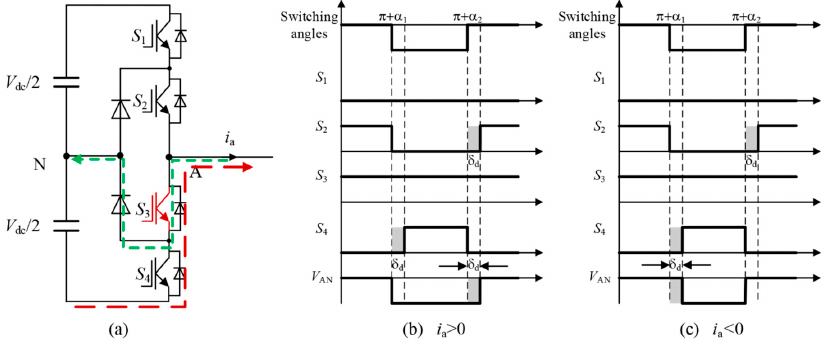
Figure 5. Current path ( a ), and output voltage during dead time, when i a > 0 ( b ), and i a < 0 ( c ), in the Figure 6. Current path ( a ), and output voltage during dead time, when 𝑖 (cid:3028) (cid:3408) 0 ( b ), and 𝑖 (cid:3028) (cid:3407) 0 ( c ), in positive half cycle of the modulation the negative half cycle of the modulation voltage.